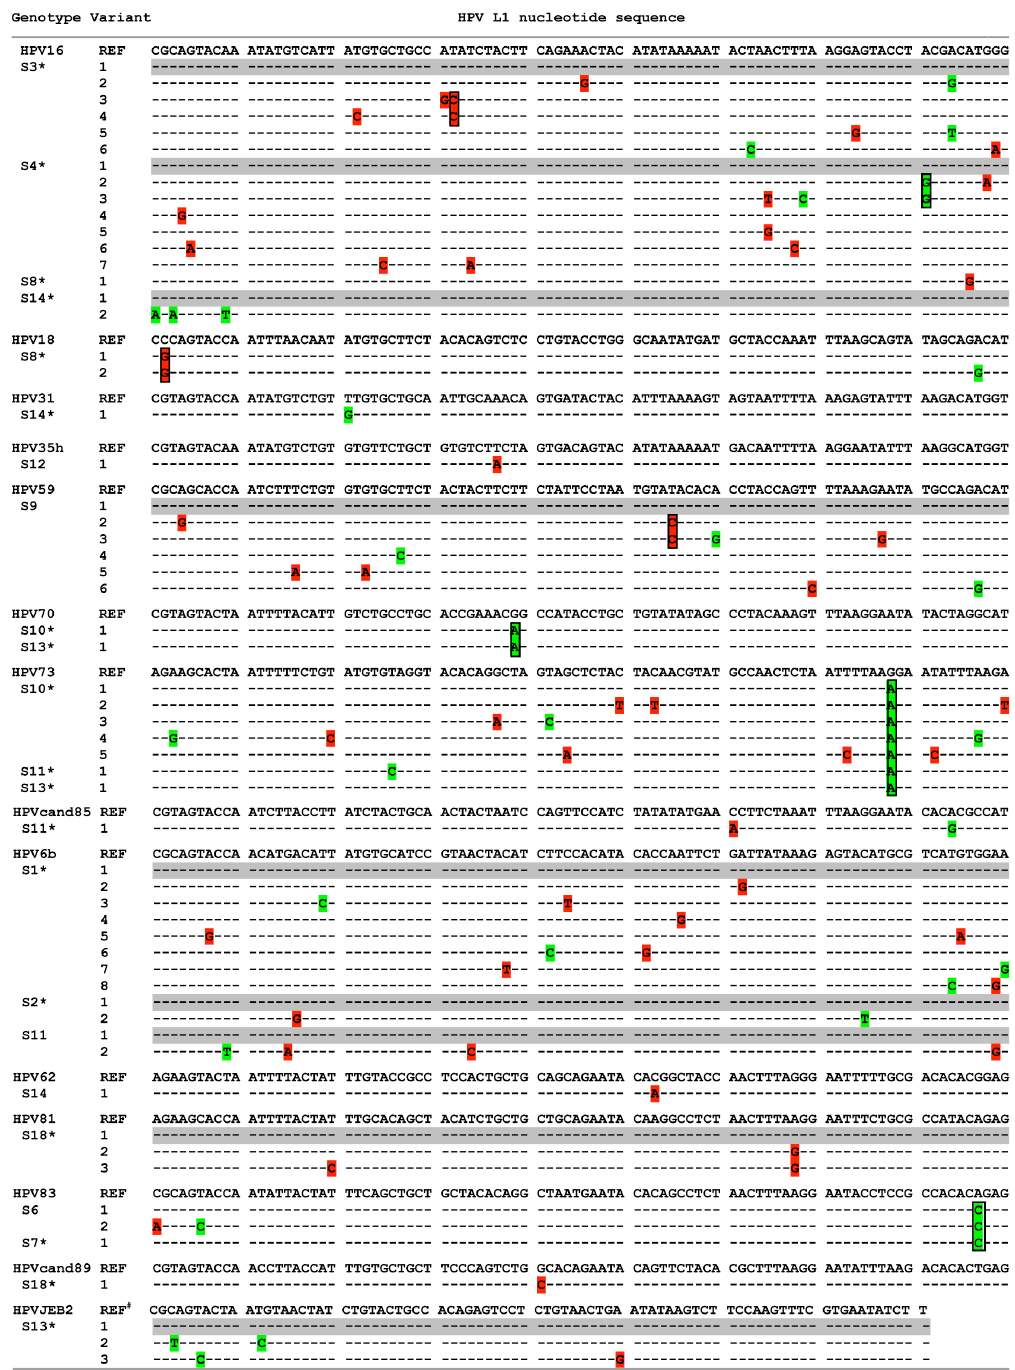
Figure 4. HPV L1 variants within genotypes. HPV L1 nucleotide sequence(s) of genotype variant(s) were aligned to corresponding reference genotype sequences with grey color highlighting variants identical to reference sequences. Synonymous and nonsynonymous nucleotide differences were highlighted by green and red, respectively, and boxed to indicate the same nucleotide substitution in more than one variant of an HPV genotype in one or multiple individuals. Nucleotide positions in HPV L1 sequences were based on L1 region of reference sequences (nucleotides 1123 to 1212 for HPV16; 1195 to 1290, HPV18; 1051 to 1137, HPV31; 1006 to 1098, HPV35h; 1052 to 1141, HPV59; 1006 to 1095, HPV70; 1006 to 1095, HPV73; 1012 to 1098 for HPVcand85; 1000 to 1089 for HPV6b; 67 to 156 for HPV62; 1018 to 1107 for HPV81; 1018 to 1107 for HPV 83; 1066 to 1153 for HPVcand89, and 15 to 95 for HPVJEB2 (#: partial L1 reference sequence)). * sample with variant(s) failed to be typed by